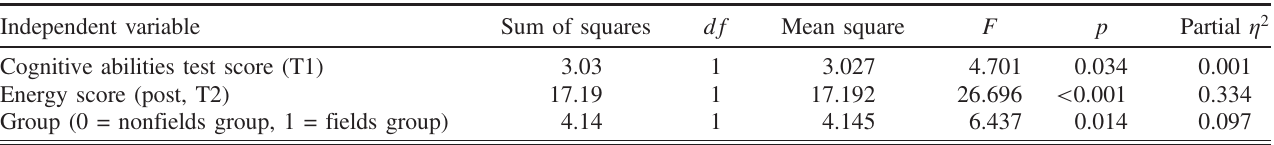
TABLE IV. Results of the ANCOVA with students ’ understanding of electric energy after the subsequent units (T4) as dependent